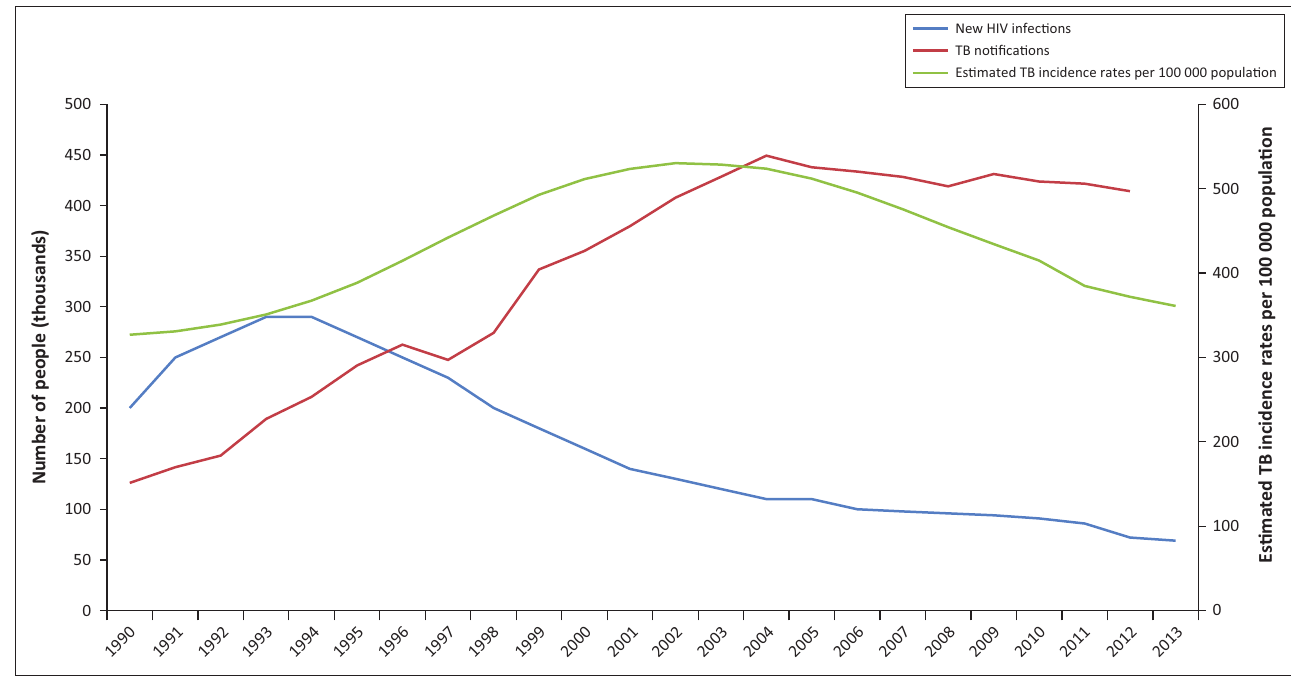
Source : (1) Data extracted from http://www.who.int/tb/country/data/download/en/ (2) Data extracted from http://aidsinfo.unaids.org/ TB, tuberculosis; WHO, World Health Organization. FIGURE 1: Tuberculosis incidence and notification rates. Estimated tuberculosis incidence rates per 100 000 population and tuberculosis notifications reported to WHO (1) are presented, along with new HIV infections reported to the UNAIDS database (2) between 1990 and 2013 in 18 sub-Saharan African countries (Southern and Eastern Africa, excluding South TABLE 1: Key strengths, weaknesses, opportunities and threats for tuberculosis laboratory services in Africa. † Strengths